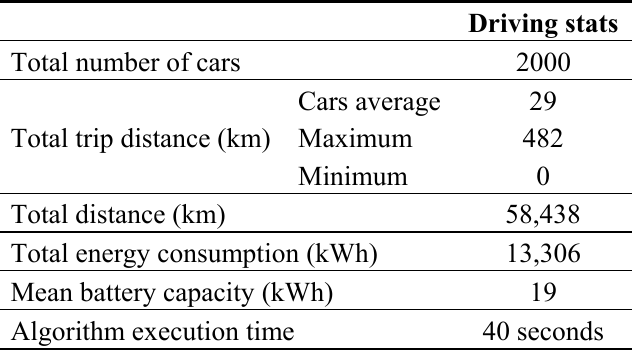
Table 10. Scenario stats 33 bus